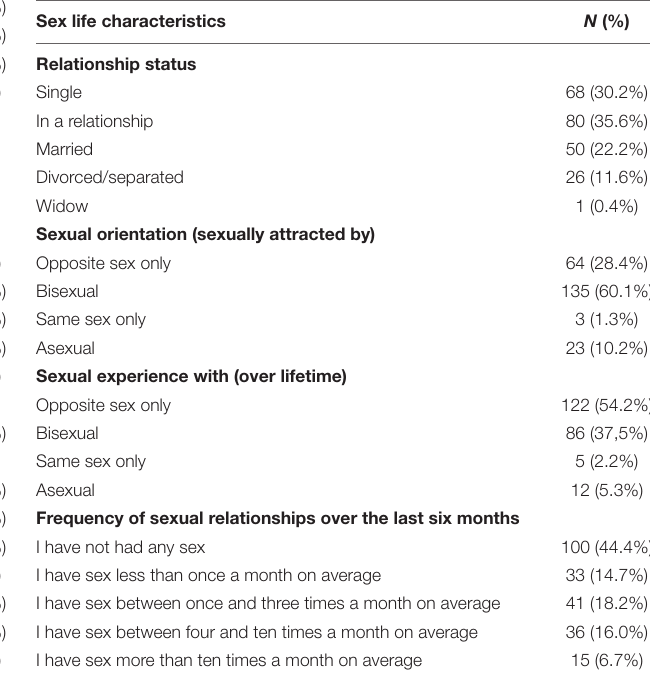
TABLE 3 | Sex life characteristics of